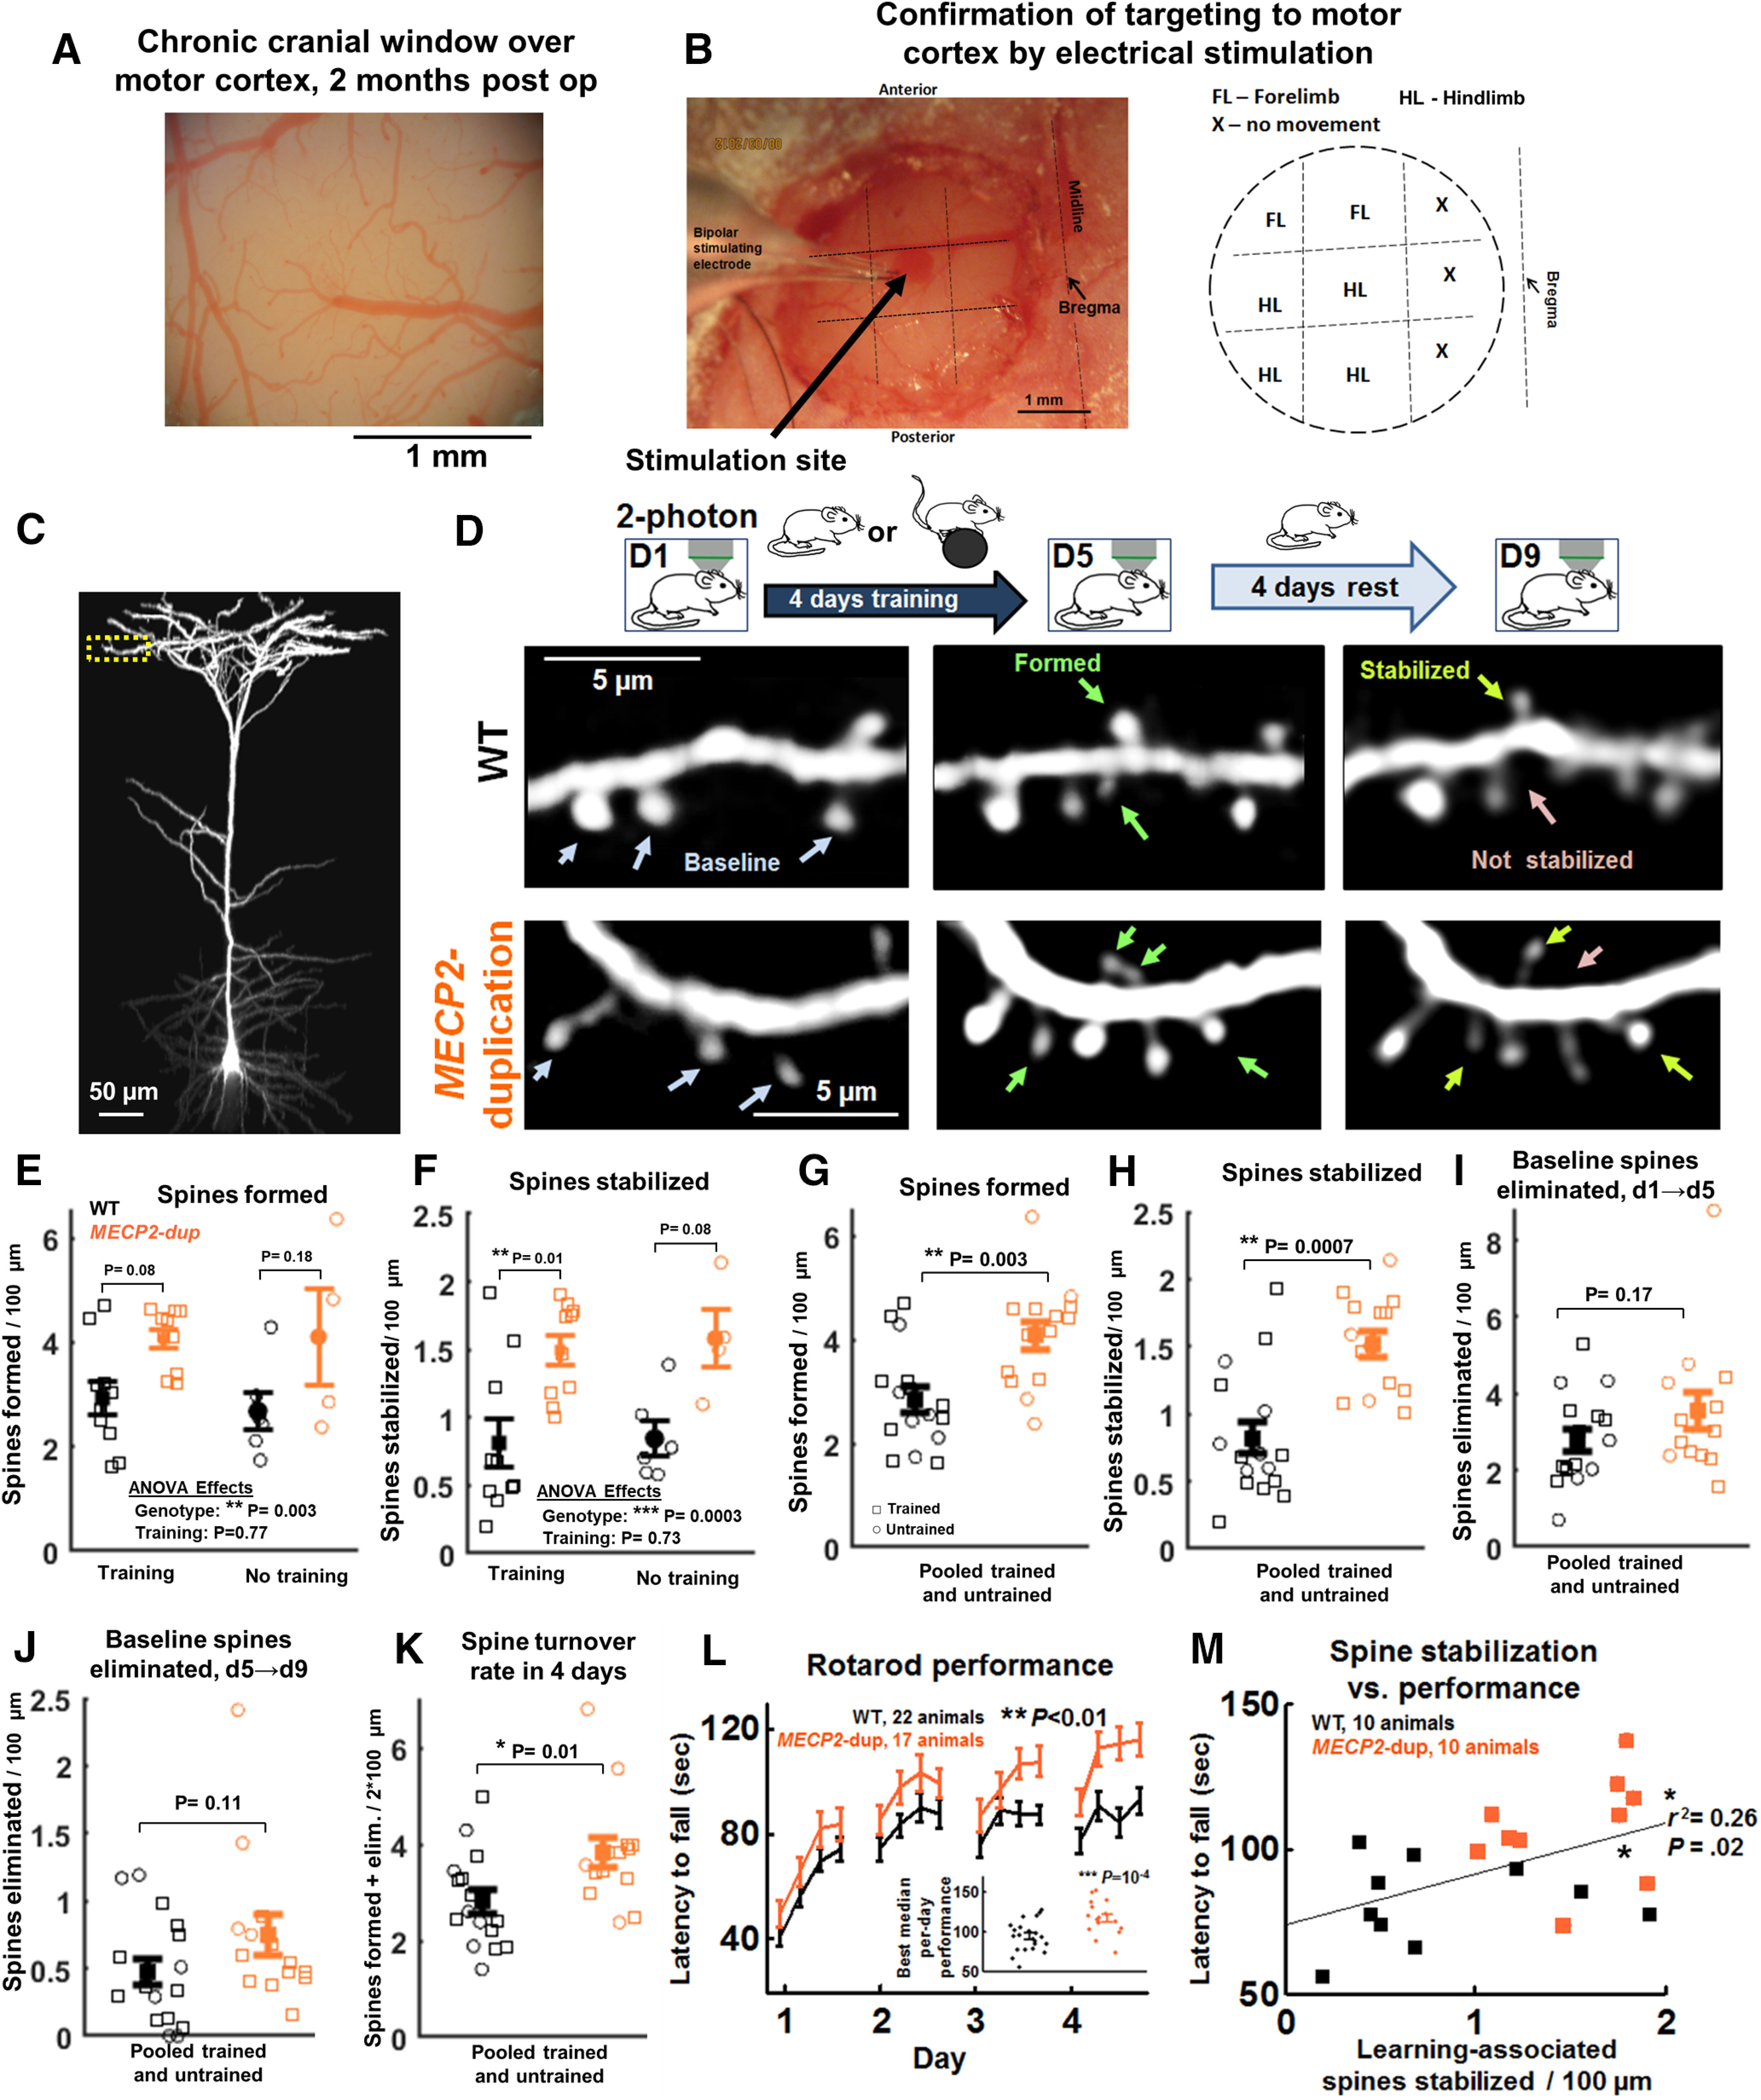
 Increased formation and stabilization of dendritic spines in L5 pyramidal neuron apical dendrites of MECP2-duplication mice. A, Example brightfield image of chronic cranial windows over M1 at two months postoperative, showing the well-defined vasculature and pale gray matter characteristic of high-quality preparations. B, left, Image demonstrating the microstimulation experiment, performed post hoc in experimental mice at the end of imaging. A bipolar stimulating electrode was lowered ∼750 μm into the window at nine sites in a 1000-μm grid. Right, Example map of motor cortex generated by microstimulation. Forepaw and hindpaw twitches were generated at low currents in all stimulated cortices (n = 10 mice), confirming localization to M1. C, The dendritic tree of a GFP-labeled L5 complex-tufted pyramidal neuron in area M1 imaged by in vivo two-photon microscopy. Apical tuft terminal dendrites are targeted for time-lapse imaging (yellow box). D, Experiment paradigm: sample images of dendritic segments imaged at baseline (left), 4 d later (middle), and 8 d later (right). Some mice were trained on the rotarod daily while others were left to rest in the cage between D1 and D5. Top, WT controls. Bottom, MECP2-duplication animals. White arrows point to spines present at baseline, green to newly-formed spines, light-green to stabilized spines, and pink to non-stabilized spines. E, Spines formed per 100 μm with and without motor training in terminal dendritic branches of MECP2-duplication animals (orange, training: n = 10 animals, 300 spines formed, 82 dendritic branches; no training: n = 4 animals, 56 spines formed, 27 dendritic branches) and WT littermate controls (black, training: n = 10 animals, 276 spines formed, 99 dendritic branches; no training: n = 6 animals, 42 spines formed, 35 dendritic branches). Squares and circles depict individual data points for trained and untrained animals, respectively. Effect of genotype: ** p = 0.003, F(1,26) = 10.3; effect of training: p = 0.77; interaction: p = 0.7; two-way ANOVA across animals); p values in plot show Tukey-corrected pairwise ANOVA comparisons. F, Newly-formed spines stabilized per 100 μm in each genotype. Effect of genotype: ***p = 0.0003, F(1,26) = 17; training: p = 0.7; interaction: p = 0.88; p values in plot show Tukey-corrected pairwise ANOVA comparisons. G–K, Dendritic spines formed, stabilized, and eliminated, and overall spine turnover rate in L5 apical dendritic arbors with data pooled between trained and untrained animals, in MECP2-duplication mice (orange: n = 14 animals, 356 spines formed, 109 dendritic branches) and WT littermate controls (black: n = 16 animals, 318 spines formed, 134 dendritic branches). Squares and circles depict individual data points for trained and untrained animals, respectively. G, Spines formed per 100 μm, **p = 0.003, Mann–Whitney U test. H, Newly-formed spines stabilized per 100 μm, ***p = 0.0007. I, Baseline spines eliminated between experiment days 1 and 5, p = 0.17. J, baseline spines eliminated between experiment days 5 and 8, p = 0.12. K, Overall spine turnover rate (spines formed + spines eliminated/2 × total dendritic length) in 4 d (from day 1 to day 5), *p = 0.01. L, Mean per-trial rotarod performance (time spent on the accelerating rotarod before falling) across animals in MECP2-duplication animals (orange, n = 17) and WT controls (black, n = 22). This panel contains a larger sample size than other panels, because mice excluded from imaging analysis because of poor imaging quality but who still underwent rotarod training were included; **p = 0.009, effect of genotype, F(1,37) = 7.6, repeated-measures ANOVA. Effect of time: p < 0.0001, F(15,37) = 29.8; interaction: p = 0.47, F(15,37) = 0.99. M, Scatter plot of learning associated spines that stabilized versus rotarod performance per animal, in imaged MECP2-duplication mice (orange squares) and WT controls (black squares); *p < 0.05, r2 = 0.26, n = 20 mice pooled across genotypes, Pearson correlation, Student’s t test. Error bars indicate mean ± SEM. See Extended Data Figure 1-1 for visualization of data as estimation plots with bootstrap-estimated differences between groups (see Materials and Methods).